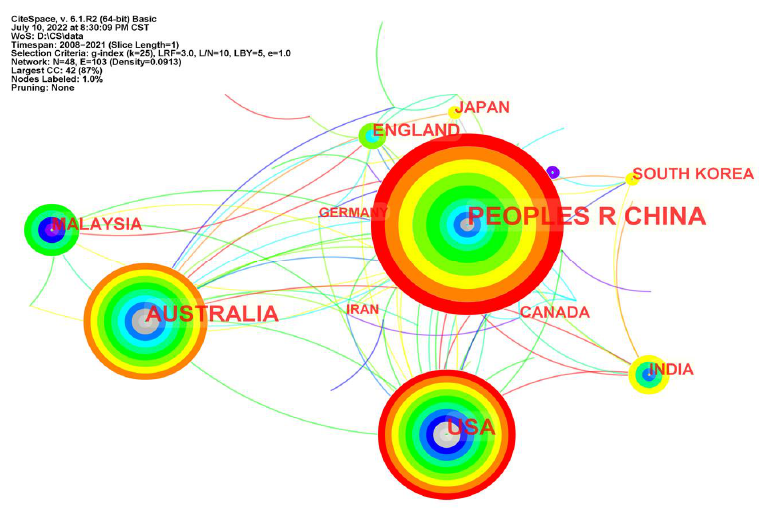
Figure 24. National co-occurrence atlas.